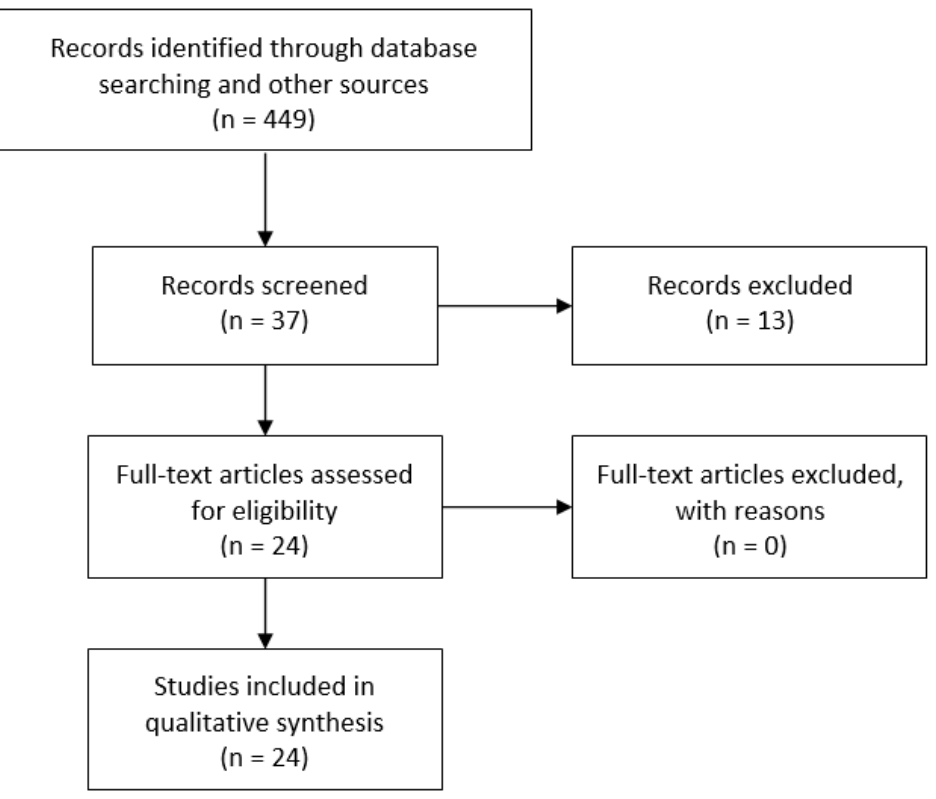
Figure 2. PRIMA flow diagram of literature search.